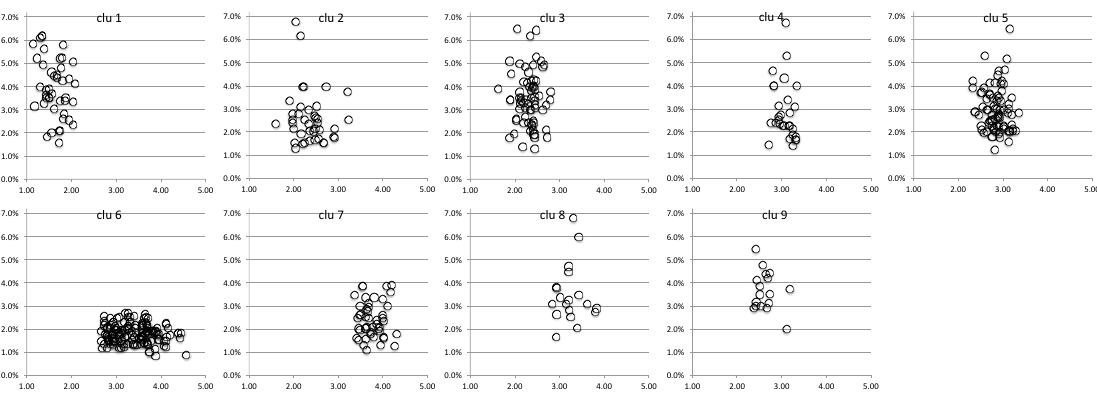
Figure 11. Cap rate by cluster: the relationship between cap rate and overall